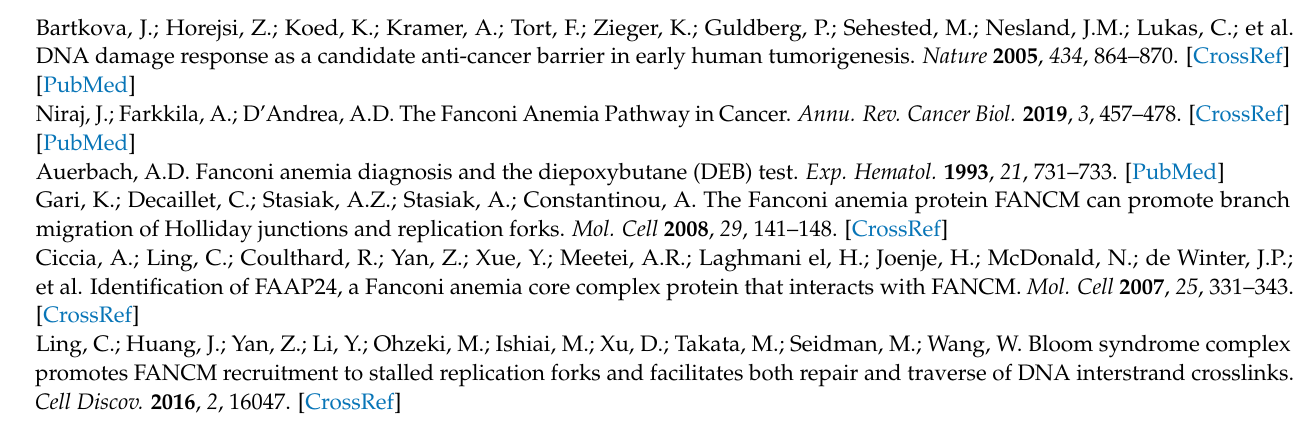
platinum, Figure S2: Platinum drugs do not induce a preference for glycolysis, Figure S3: Validation of PFKFB3 association to chromatin, Figure S4: Nuclear recruitment of PFKFB3 upon DNA damage induction by interstrand crosslinking agents, Figure S5: ATR and FANCM dependent PFKFB3 foci induction, Figure S6: PFKFB3 stimulates recruitment of FA repair factors and interacts with FANCD2 and γ H2AX at the chromatin, Figure S7: Targeting PFKFB3 induces defects in fork progression upon platinum treatments leading to fork collapse, Figure S8: Uncropped western blots from Figure 2B, Figure S9: Uncropped western blots from Figure S3a,b, Figure S10: Uncropped western blots from Figure 2F, Figure S11: Uncropped western blots from Figure S5b,e, Figure S12: Uncropped western blots from Figure 4D, Figure S13: Uncropped western blots from Figure S6b,c, Figure S14: Uncropped western blots from Figure 1G, Table S1: Antibodies used in the